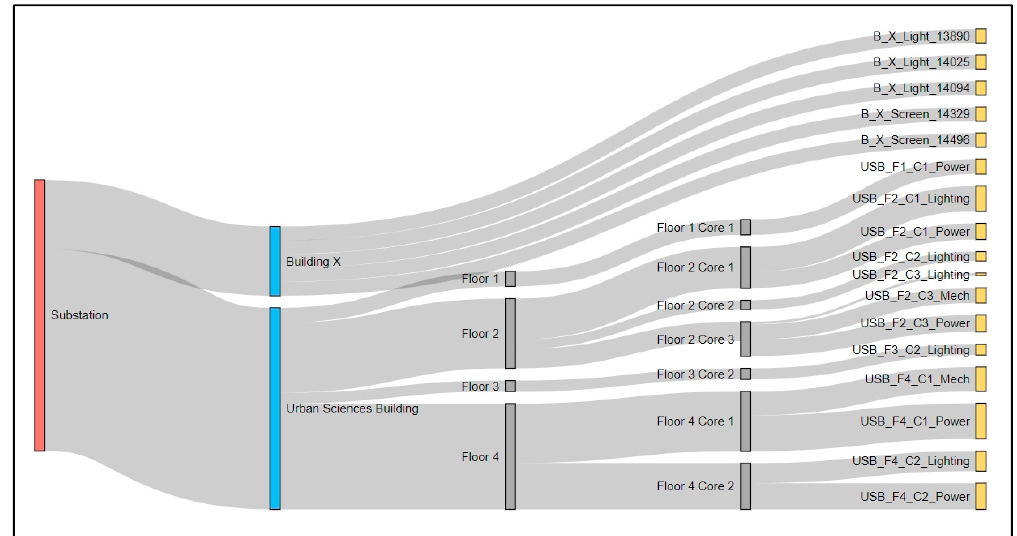
Figure 9. A depiction of the web ‐ based software system developed to exploit the integration and simulation system of Figure 1 for the case study.